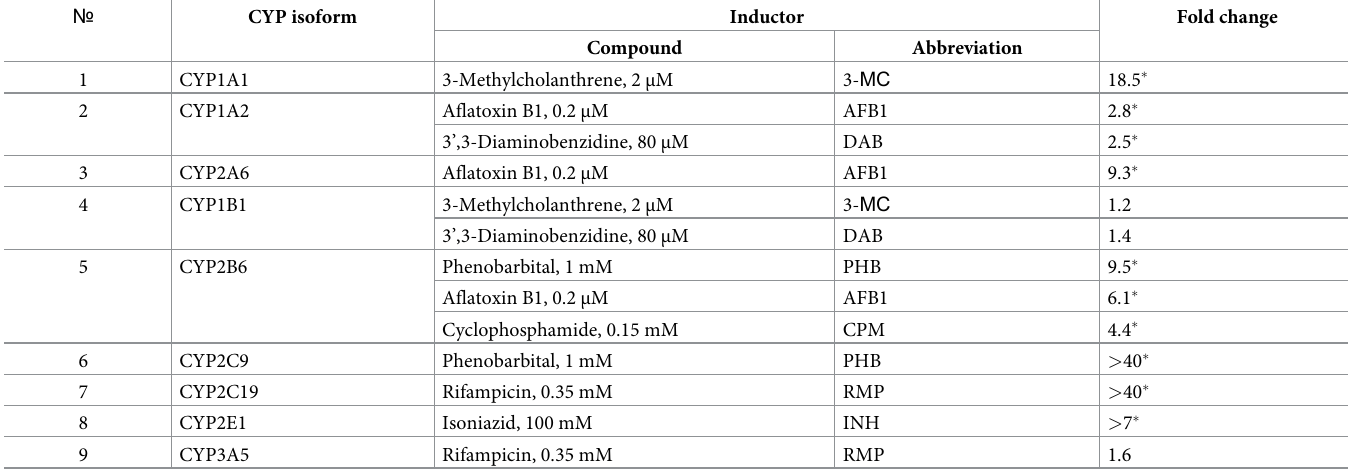
Table 1. mRNA induction of CYP isoforms in HeLa TI